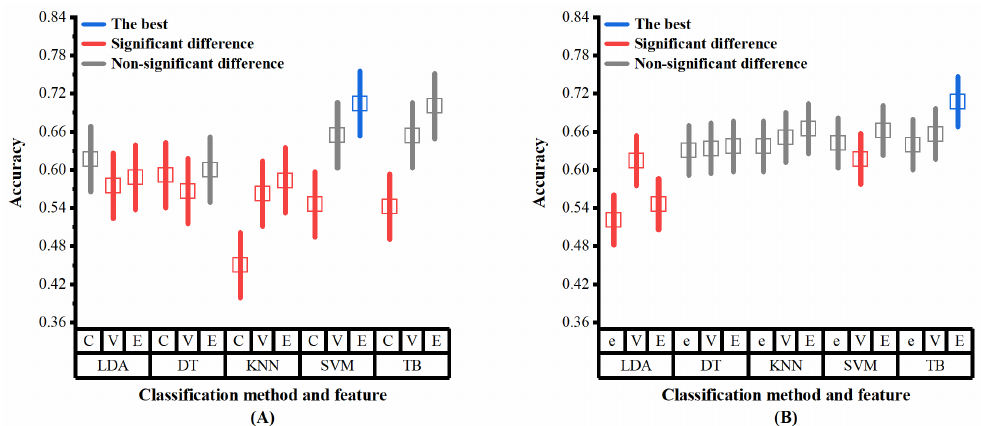
Figure 8. Multiple analysis results (classifiers and features as factors) on the two datasets: ( A ) dataset ADReSS; ( B ) dataset ADReSSo. C, ComParE; V, VAD Pause; E, ensemble; e, eGeMAPS. Blue lines represent the optimal performance, red lines represent significant difference from the optimal performance, gray lines represent non-significant difference from the optimal